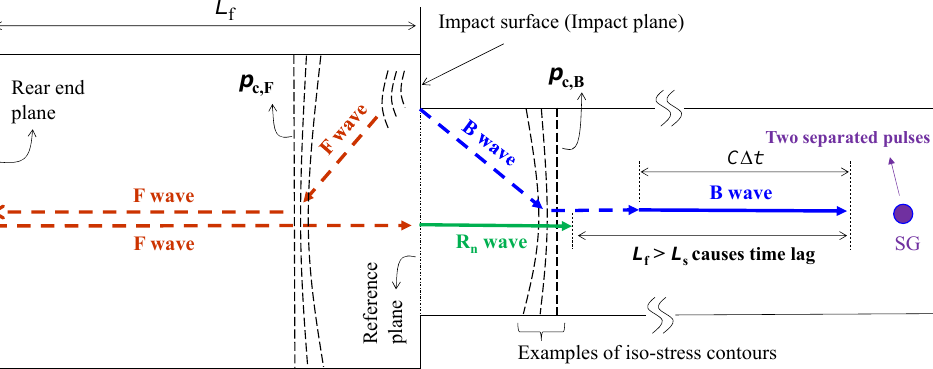
Figure 5. B, F, and R n waves when the flange length is long ( L f > L s ). The solid arrows indicate the waves in the current moment, whereas the dashed arrows describe their trajectories. For simplicity, the R n waves in the flange structure are not shown ( Δ t : pulse duration period, C : speed of sound, and SG: strain gage).